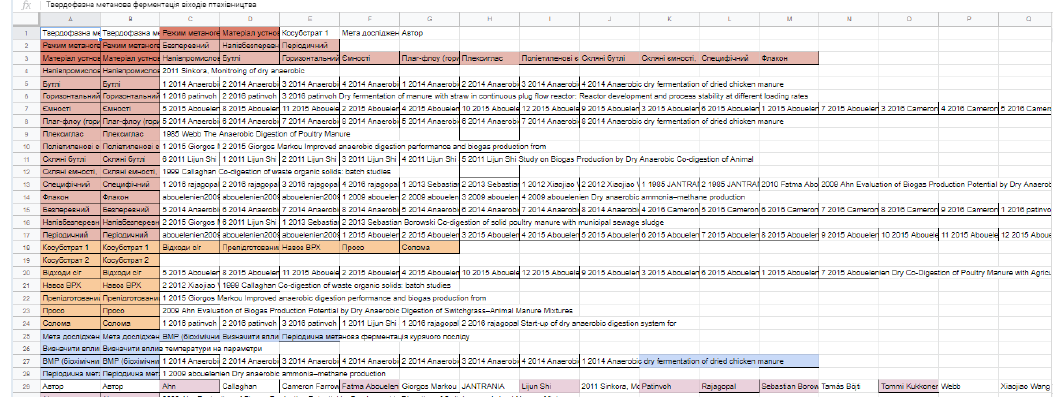
Figure 2: Google sheet with